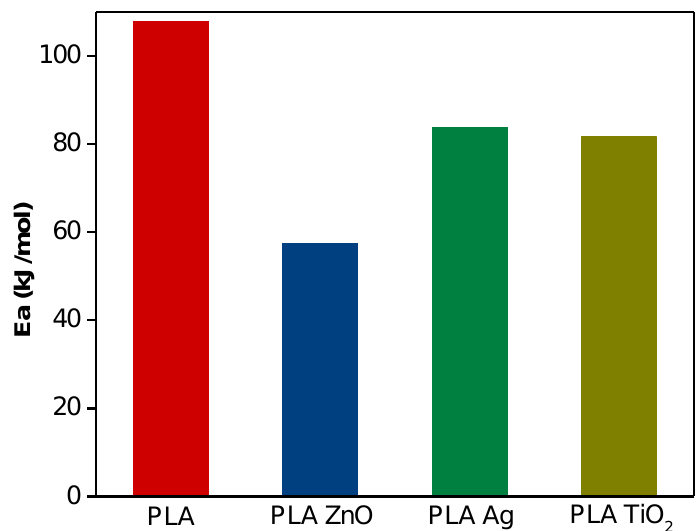
Figure 3. Activation energy of the non-isothermal cold crystallization of PLA and its nanocomposites calculated by the Kissinger method.